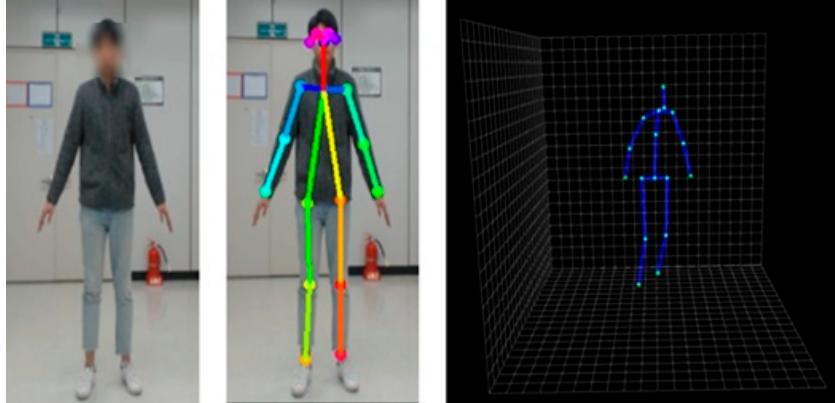
Figure 2. 3D skeleton joints obtained by the integrated pipeline.